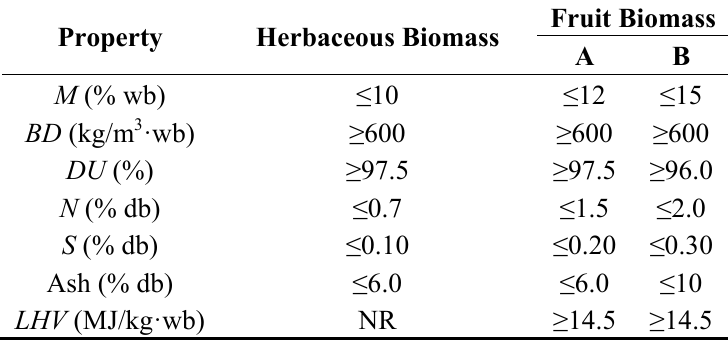
Table 3. Limit values for pellets from non-woody